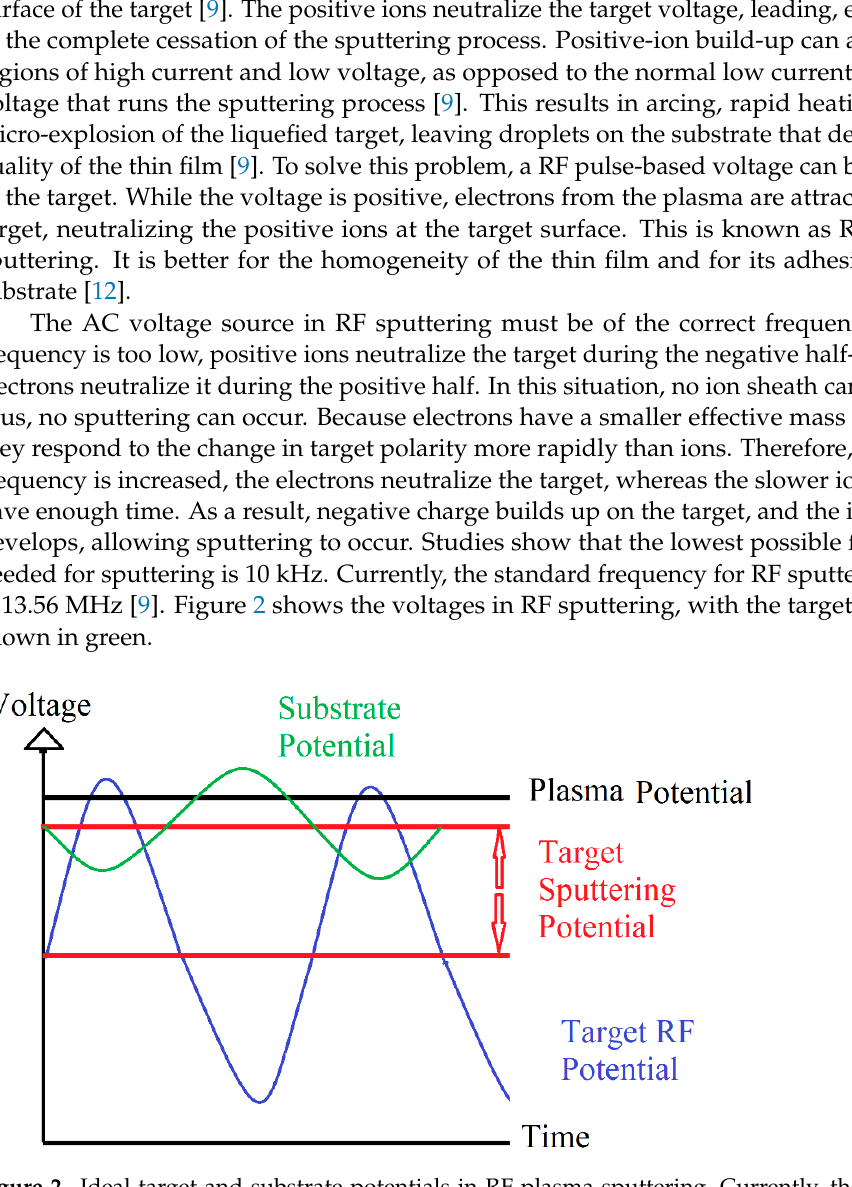
Figure 2. Ideal target and substrate potentials in RF plasma sputtering, Currently, the standard frequency for RF sputter systems is 13.56 MHz.